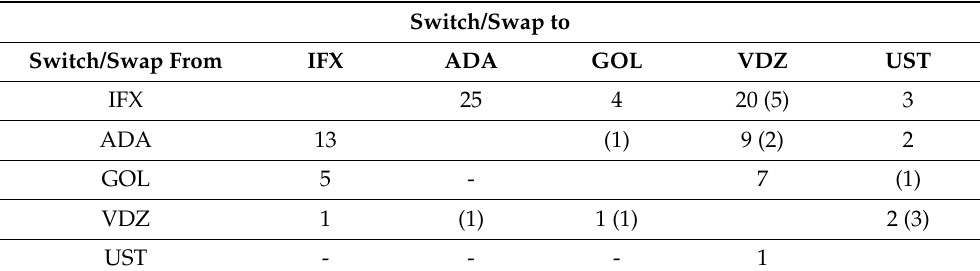
Table 3. Details on first switches/swaps biologic therapies and/or second switches/swaps therapies (in brackets) related to